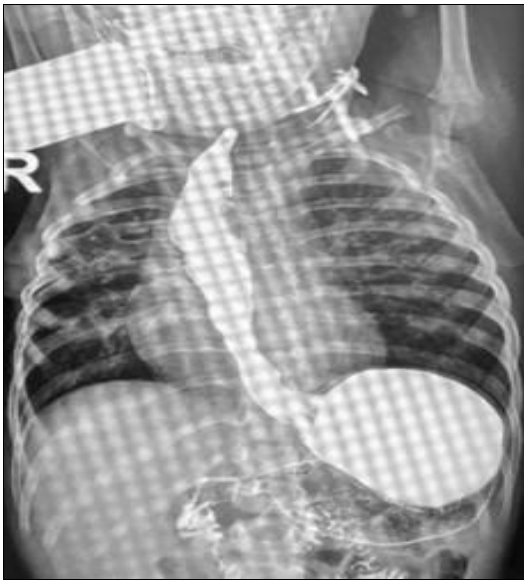
Figure 3: Follow-up contrast study after 2 years The child is on regular follow-ups for 2 years. The contrast study shows a patent but dysmorphic esophagus (Fig. 3). However, he is accepting oral feeds well. His growth parameters are in the 30-50 percentile for